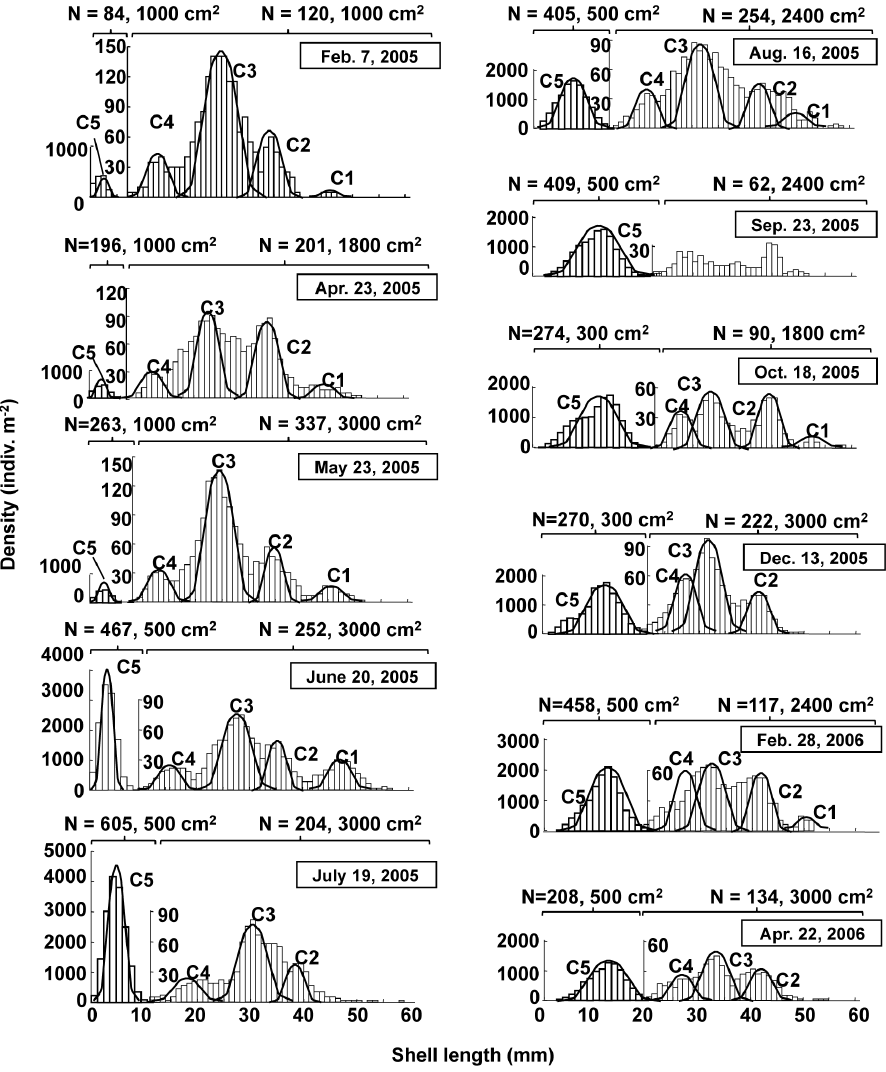
Figure 3. Size–frequency distribution of Ruditapesphilippinarum population at station B. The left and right scales correspond to samples obtained using mesh sizes of 1 and 5 mm, respectively (C=cohorts; n=number of individuals).